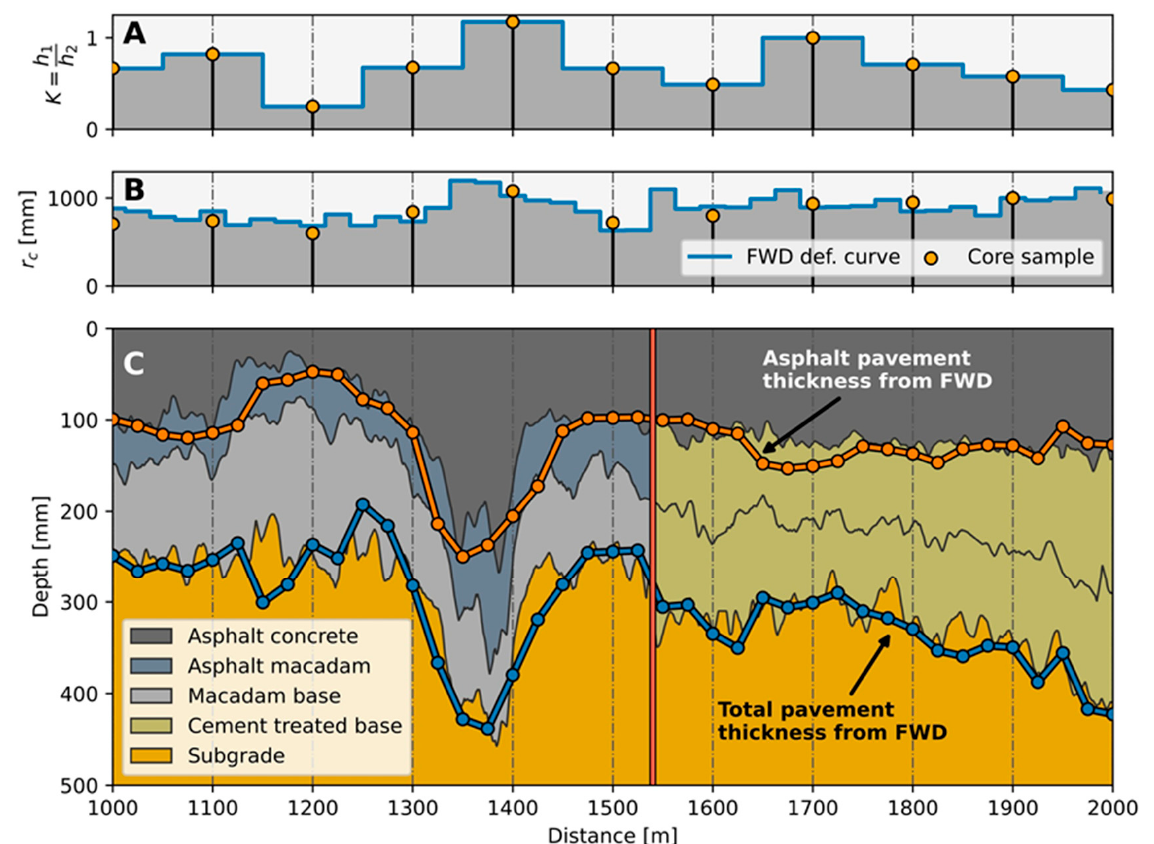
Figure 18. Total and asphalt pavement layer thickness from FWD data. ( A ) the proportion of K layer thickness based on the core samples; ( B ) the r c values from measured deflections of the FWD device; ( C ) GPR layer thicknesses vs. the total H pavement thickness from FWD data split into asphalt layer h 1 and base layer h 2 .